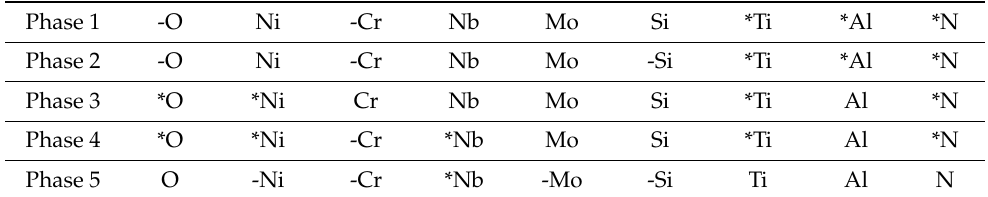
Figure 12. Regions identified as “uncommon” with components share in upper quartile, respec- tively, O ( a ), Ni ( b ), Cr ( c ) and Al ( d ).